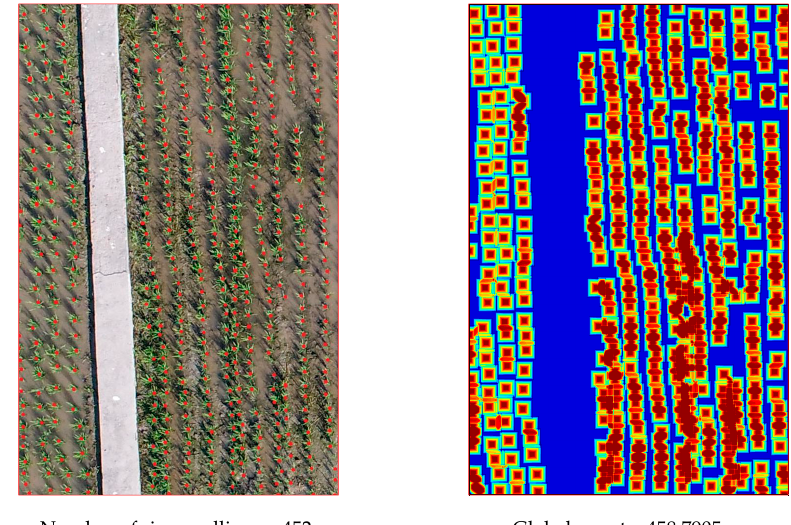
Figure 4. Example of a ground truth density map: manually-annotated cropped image ( left ) and corresponding ground truth rice seedling density map ( right ). Density map regression treats the two-dimensional density map as the regression target. Our proposed Basic Network regresses the global count computed from the global density map.